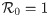
Functional dependence of the basic reproduction number from the transmission rates of undetected individuals (α and β) and the transmission rate of diagnosed individuals γ.Black surface: R0=1; Orange surface: γ = 0.01, Blue surface: γ = 0.05, Green surface: γ = 0.09. All the remaining parameters are fixed to their value at t = 0.